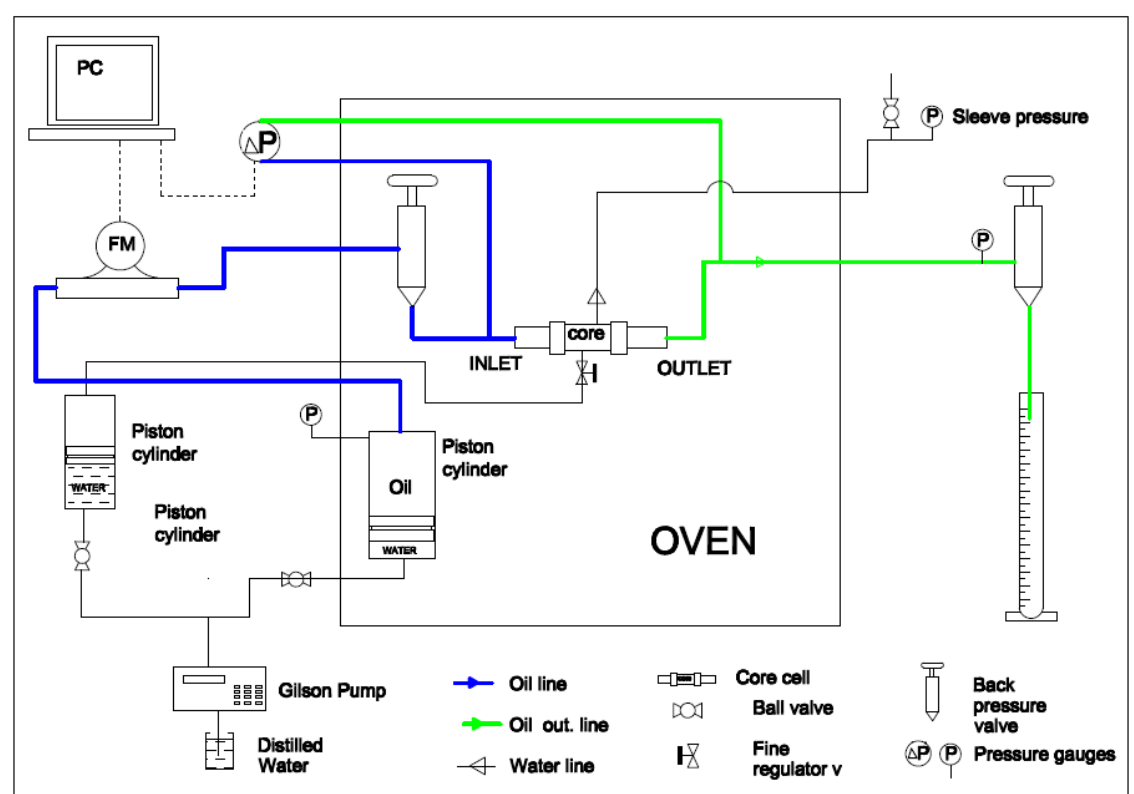
Figure 8. Schematic of the setup used for flooding